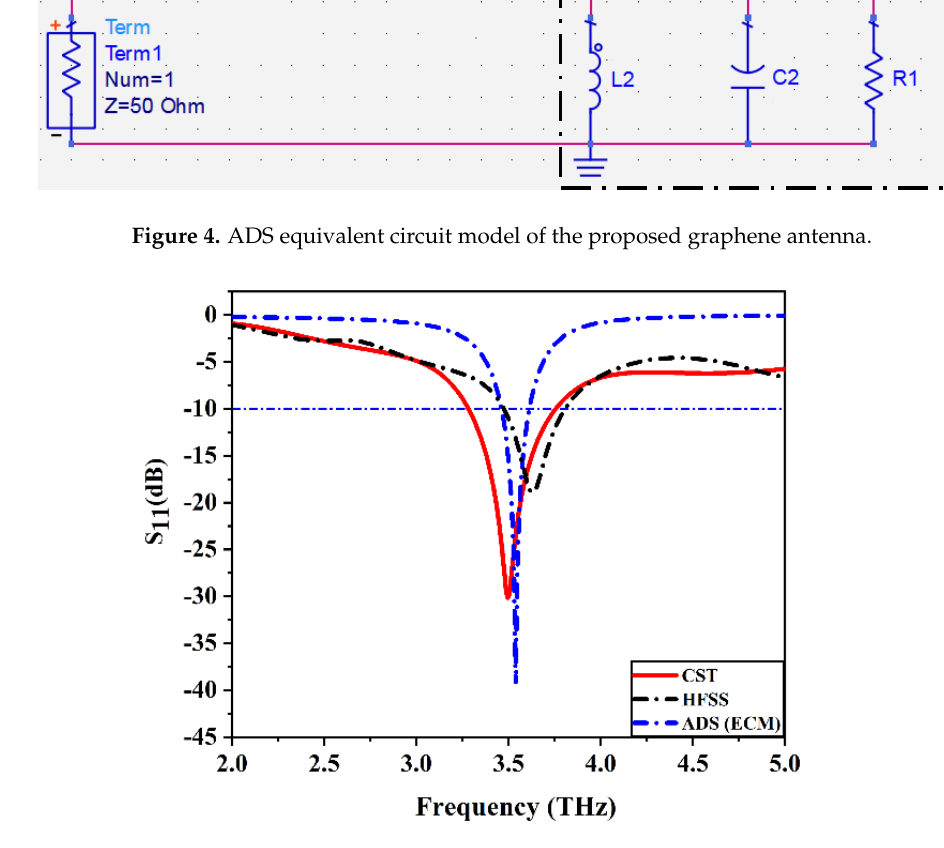
Figure 6. 3D radiation pattern of the proposed antenna . Table 1. The proposed antenna parameters .